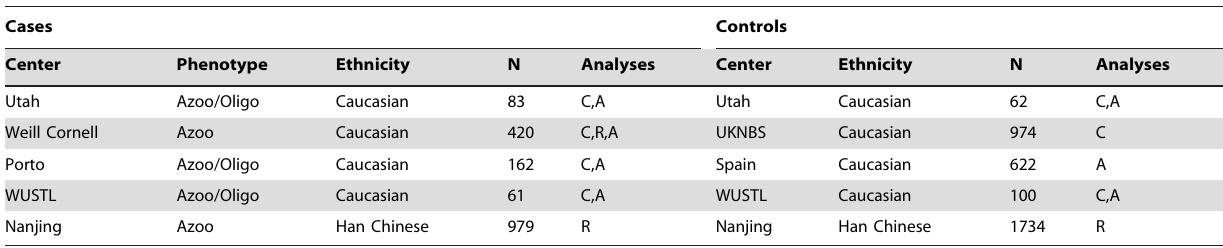
‘N’, number of individuals in the cohort after excluding ethnic outliers and samples with poor data quality. ‘Analyses’, describes whether the cohort was included in primary CNV analyses (‘C’), replication CNV analyses (‘R’), and autozygosity analyses (‘A’). Note that due to small sample sizes, the 17 Weill Cornell samples with SNP array data were merged with Porto samples and the combined set treated as a single cohort for the primary CNV analyses. Thus the total number of cases with whole- genome array data are 83 + 17 + 162 + 61=323. Many more samples were sourced from Cornell for replication analysis. Full details of each cohort are available in Text S1.